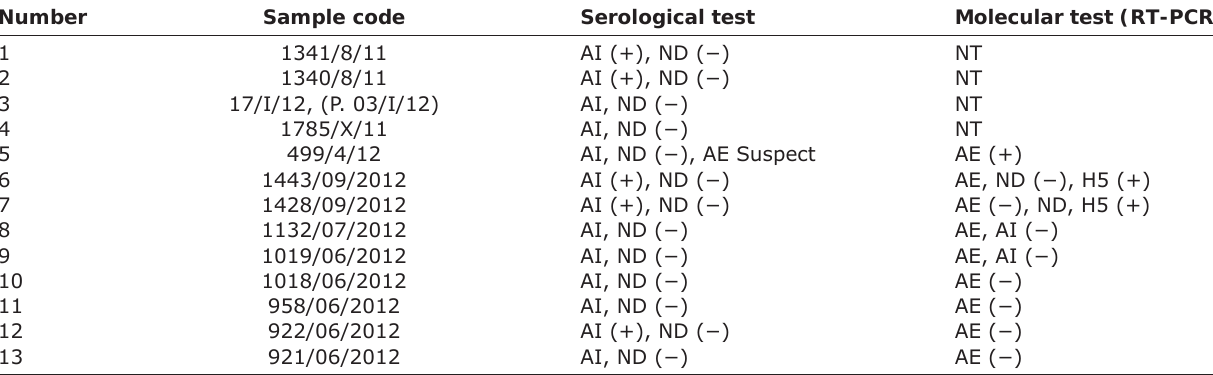
Table-3: Serological and molecular tests of 13 AEV isolates from field specimens. Number